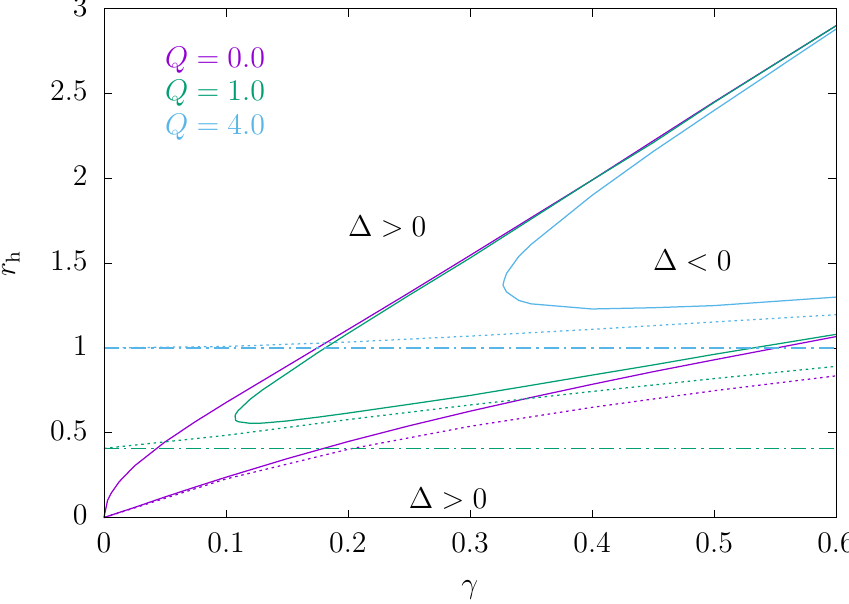
Figure 3 . We show the domain of existence of charged black holes in the (cid:13) { r h -plane for three di(cid:11)erent values of the charge: Q = 0 : 0 (purple), Q = 1 : 0 (green) and Q = 4 : 0 (blue). The solid lines (with Q increasing for the spike appearing at increasing values of (cid:13) ) de(cid:12)ne the lines on which (cid:1) = 0 and we indicate in which part of the (cid:13) { r h -plane (cid:1) is positive or negative, respectively. The dashed lines (with Q increasing from bottom to top) correspond to f 2 = 0, while the dotted-dashed lines (with Q increasing from bottom to top) represent the values for which K = 0 (see (4.19)). This latter condition gives the horizon of the corresponding extremal RNAdS solution for (cid:13) = 0. Black hole solutions with scalar-tensor hair exist above the dashed line and to the left of the (cid:1) = 0